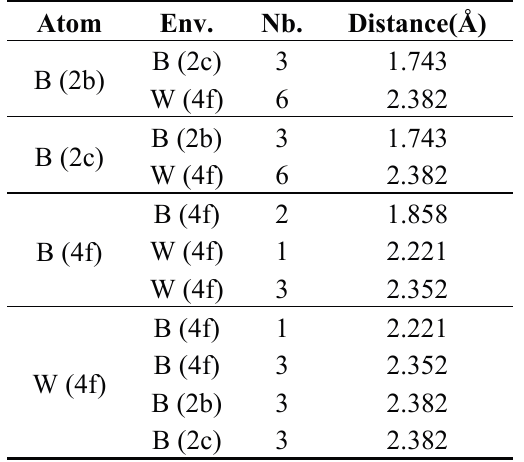
Table 6. Bond lengths in the hP12 WB 2 compound.